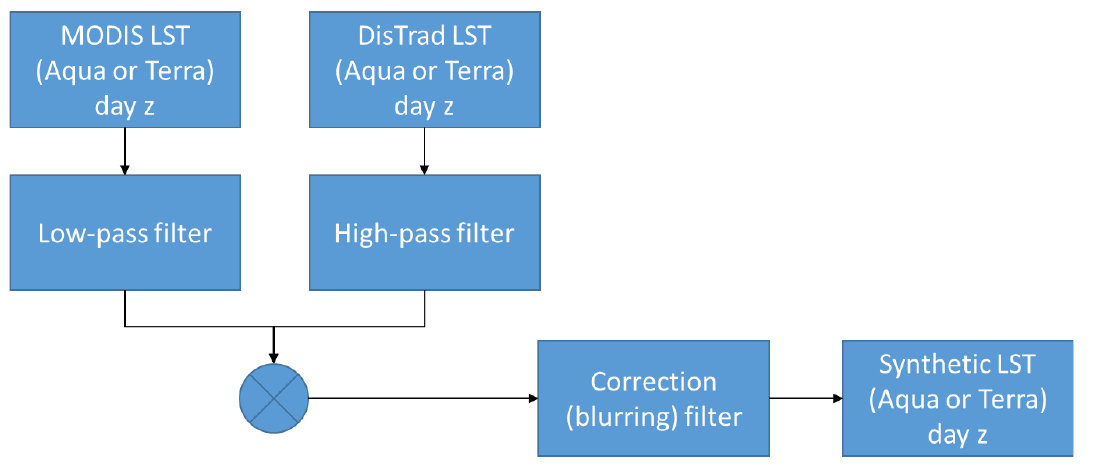
Figure 3. Flowchart—step 3—Day-specific high-resolution synthetic LST using spatial bandwidth composition and applying a post-composition correction filter.